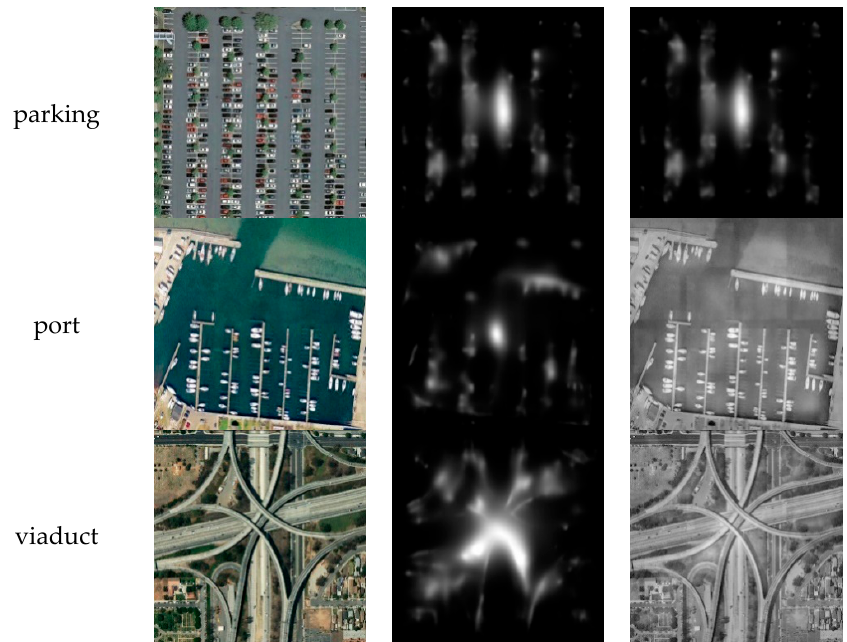
Figure 5. Samples of a 19-class dataset, SPGKDE saliency detection, and the final preprocessed images for LLC input.